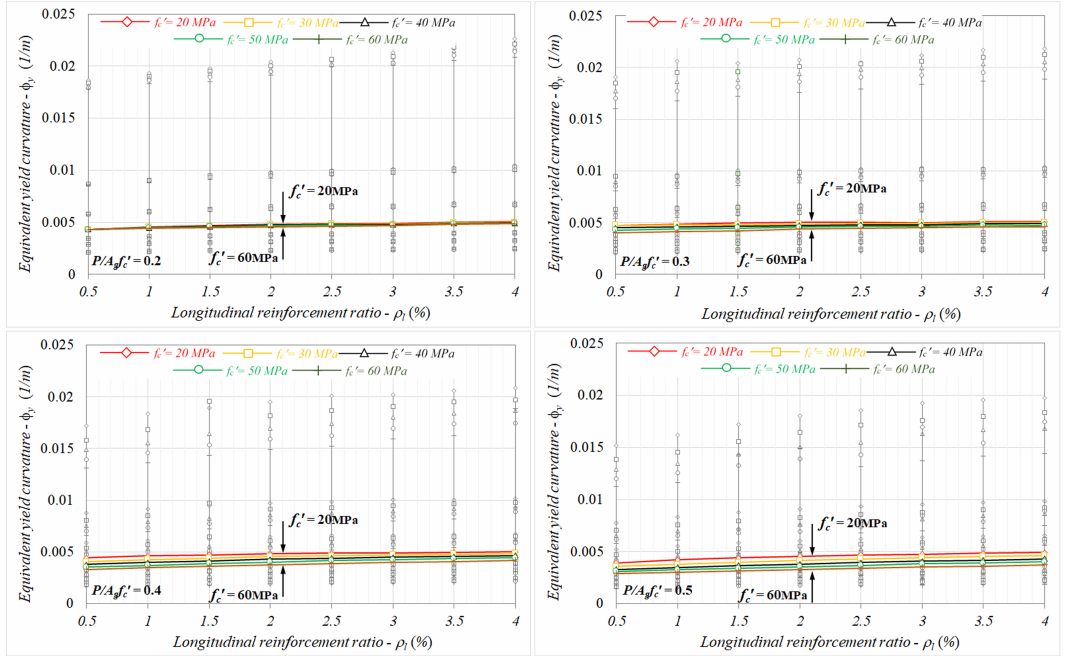
Figure 7. The variations of equivalent yield curvatures with the reinforcement ratio in terms of di ff erent ( a ) axial load levels, ( b ) column dimensions, and ( c ) concrete compressive